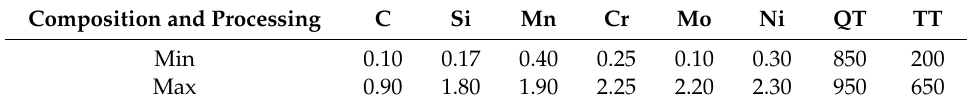
Table 5. Composition design input range.